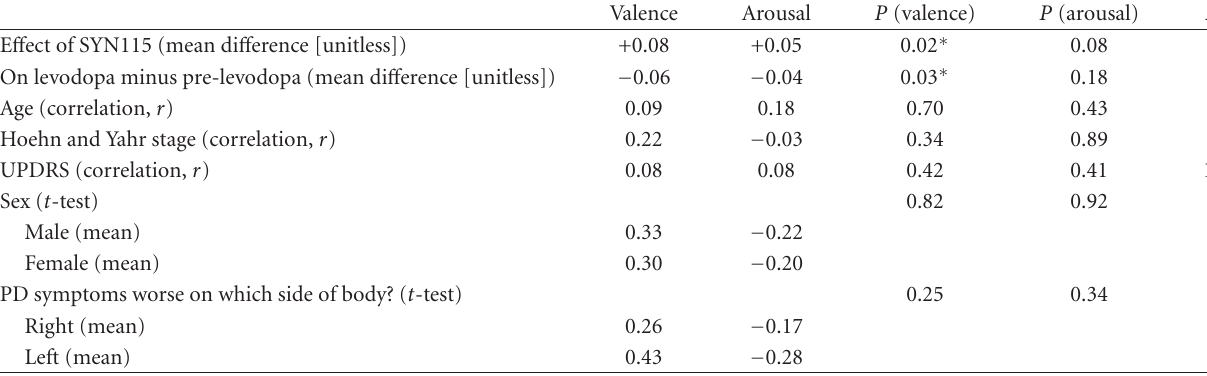
Table 2: Associations of valence and arousal with pharmacological status and demographic variables.